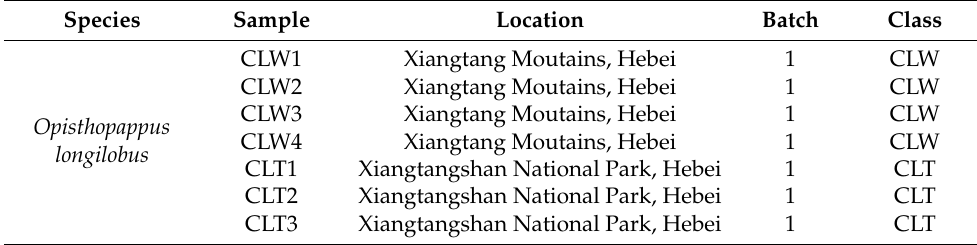
Table A4. CLT, CLW, and TH samples and location